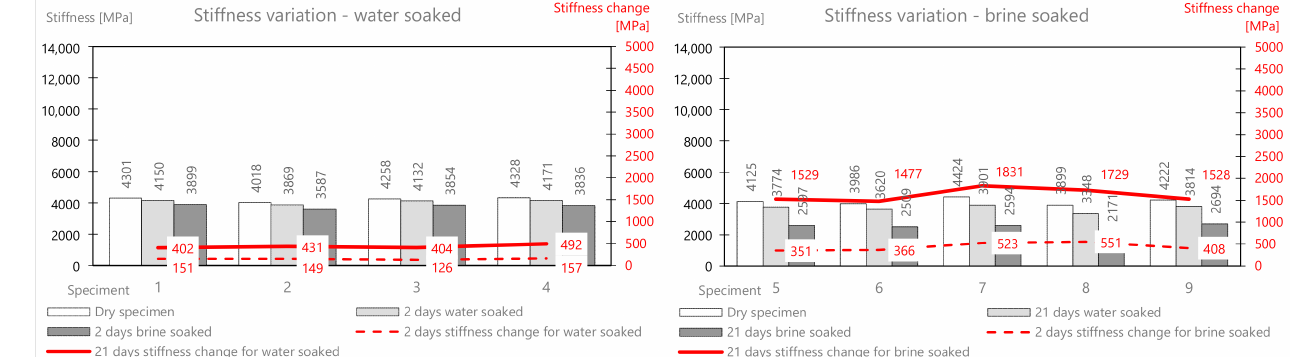
Figure 14. MCE mix stiffness variation via water and brine